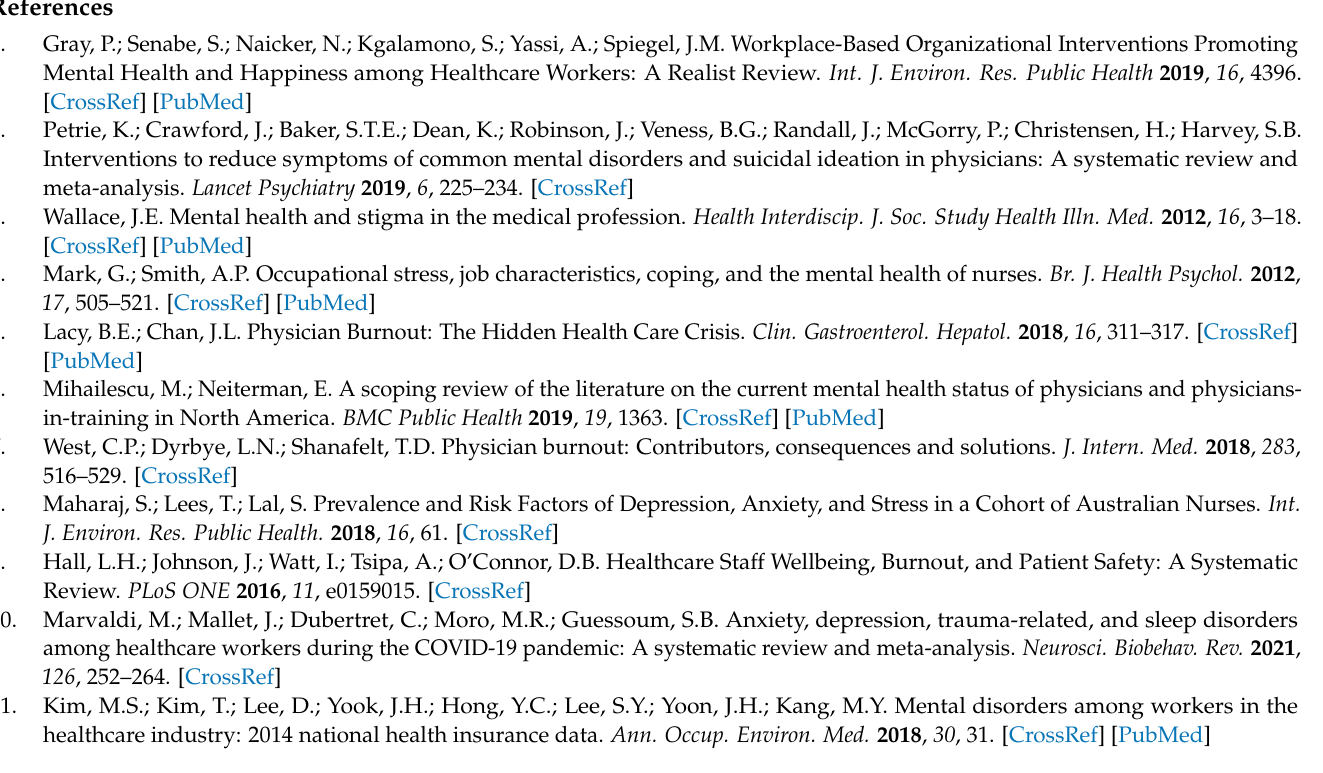
Table S4: Estimates (standard-errors) of the models. Square root transformation was applied to scores on both IES-R Avoidance and Hyperarousal